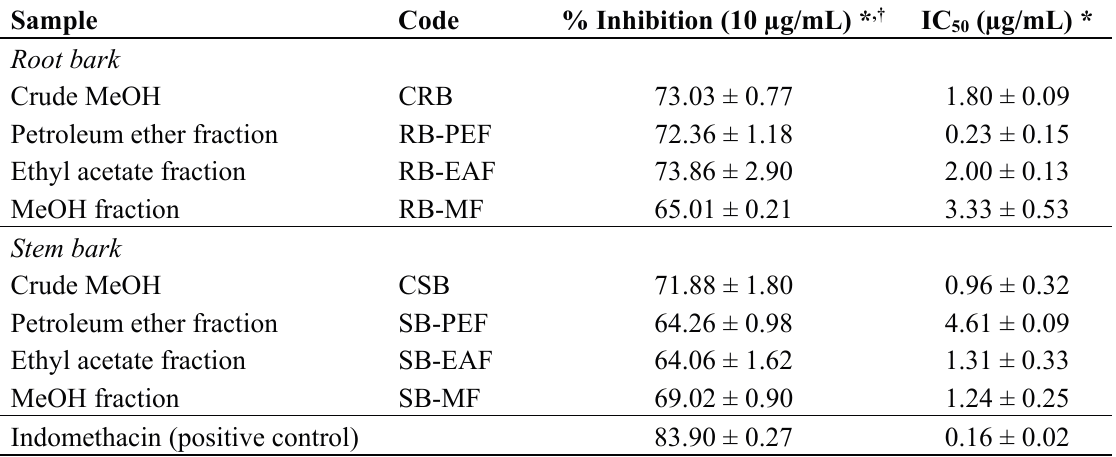
of D. serrata on production of PGE 2 in LPS-induced human whole blood.